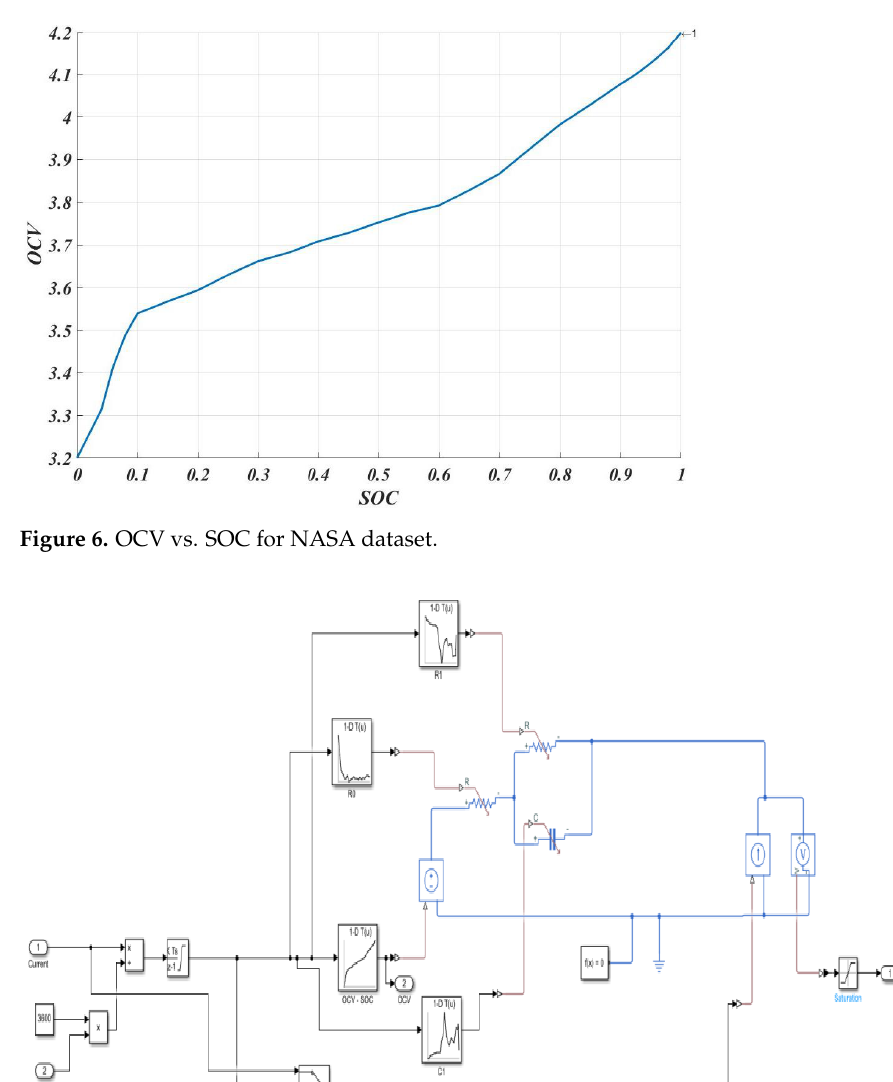
Figure 7. Cell Model developed using MATLAB/Simulink.